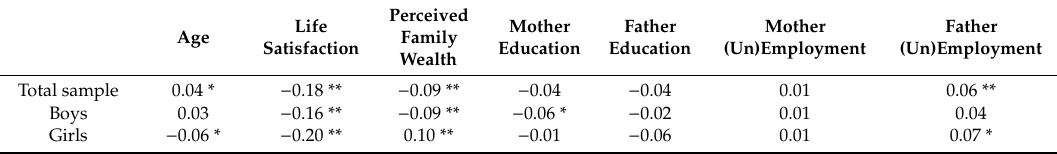
Table 2. Correlations between excessive Internet use (EIU), socioeconomic status (SES) indicators, demographic variables, and life satisfaction.